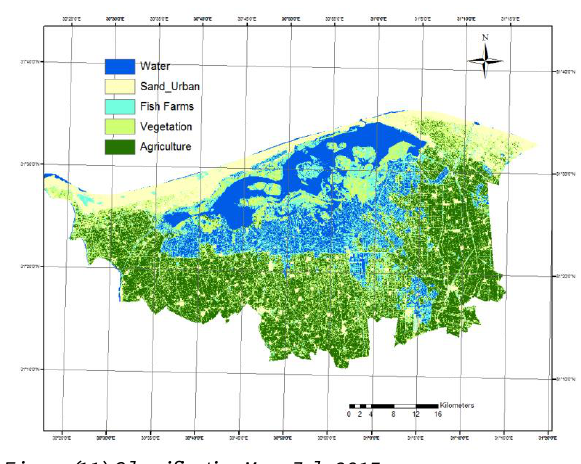
Figure (11) Classification Map July 2015 Table (2) summarizes each identified class area in three different dates plus the reported recent study was interested in classification of Lake Burullus land use. Table (2) Extracted Areas for each Lake Burullus Wetland